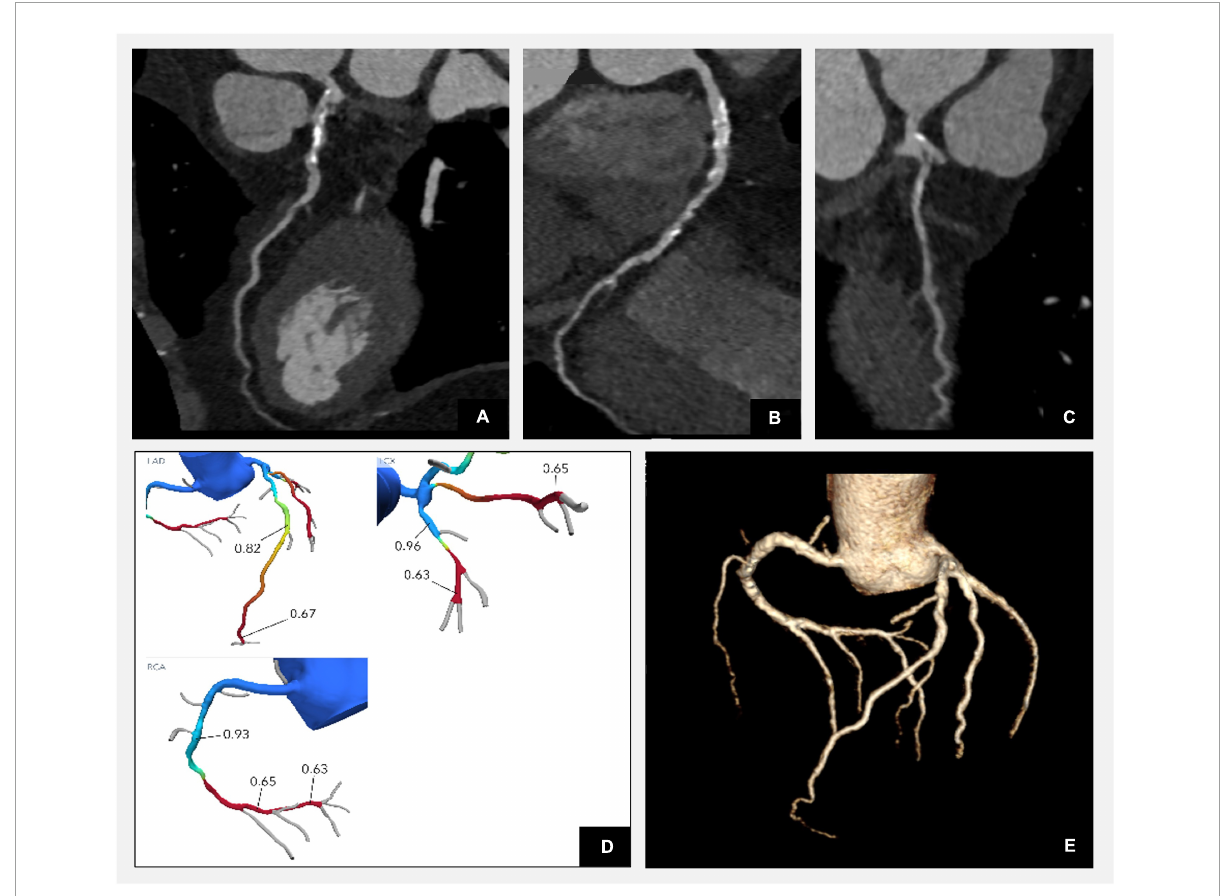
FIGURE1 Illustration of corresponding anatomical coronary CTA plaque analysis and functional assessment with FFR-CT in a patient with diabetes. Reconstructions confirm three vessel disease with diffuse mixed plaque and severe flow limiting stenoses in the distal LAD, distal RCA, and proximal intermediate branch as per FFR-CT functional analysis. (A) CTA curved multiplanar reconstruction of the left anterior descending artery (LAD) demonstrating diffuse calcific plaque disease in the proximal segment with mild stenosis and low attenuation plaque in the mid vessel with severe moderate flow limiting stenosis as per angiographic assessment. (B) CTA curved multiplanar reconstruction of the right coronary artery (RCA) demonstrating diffuse mixed plaque disease throughout the vessel with most significant stenosis in the mid segment. (C) CTA curved multiplanar reconstruction of the intermediate artery reconstruction demonstrating diffuse mixed plaque disease with severe stenosis at the ostium of the vessel. (D) Computational fractional flow reserve (FFR) CT by HeartFlow indicating haemodynamically moderate flow impairment (FFR-CT of 0.82) across the lesion in the mid segment and severe (FFR-CT of 0.67) in the distal segment of the LAD, severe stenoses in the proximal intermediate (FFR-CT of 0.65) and distal segment of RCA (FFR-CT of 0.65). (E) Three-dimensional model illustrating the reconstruction of coronary arteries (Syngovia Siemens